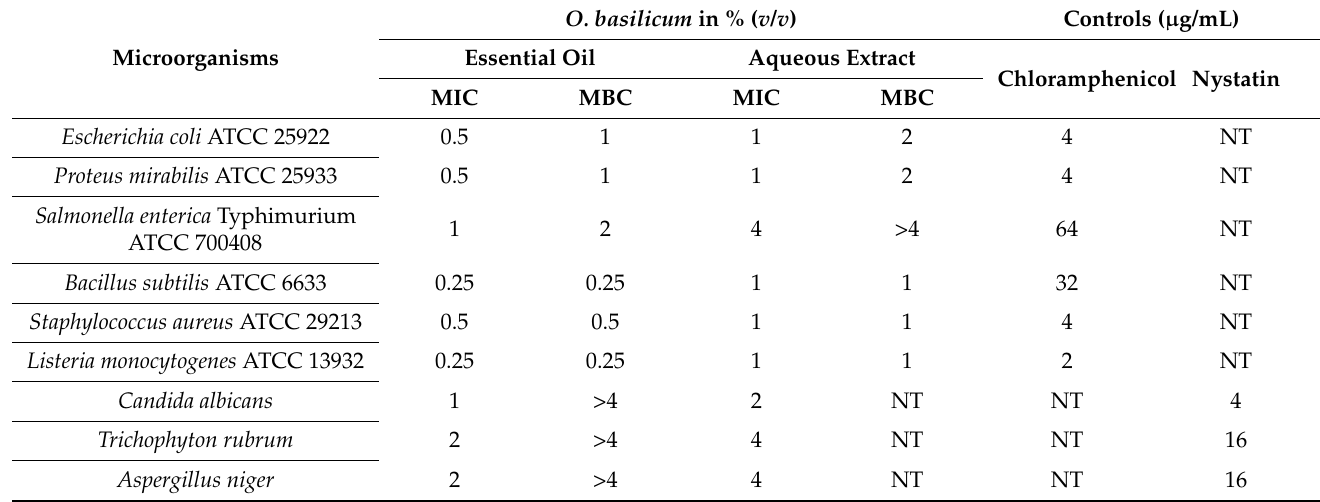
Table 4. MIC and MBC of O. basilicum EO and aqueous extract in percentage ( v / v ).